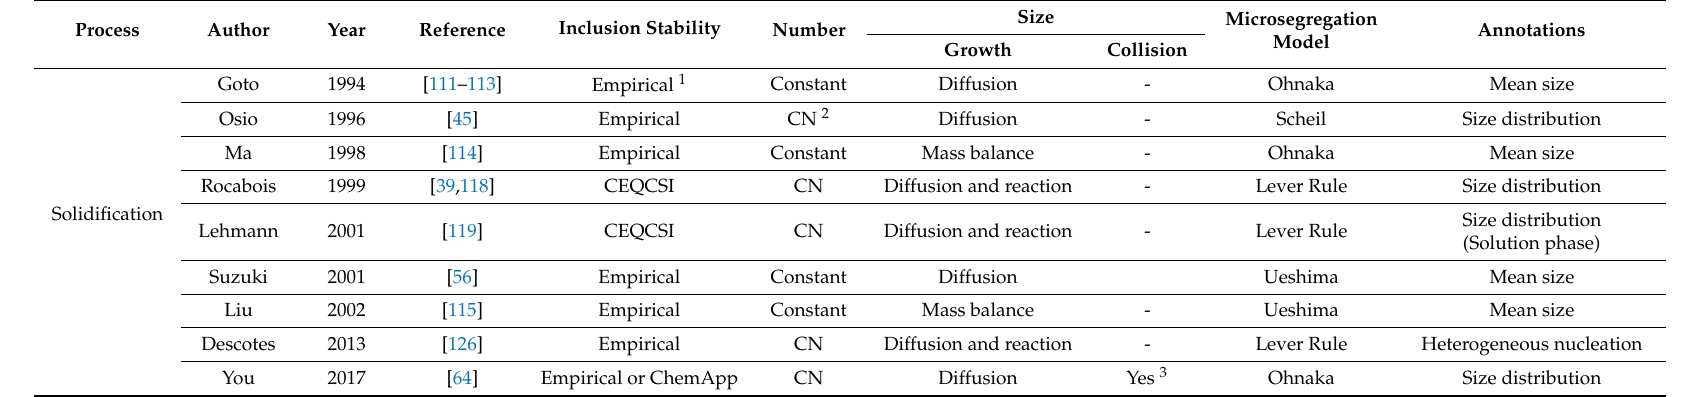
Table 3. List of kinetic models on inclusion formation during